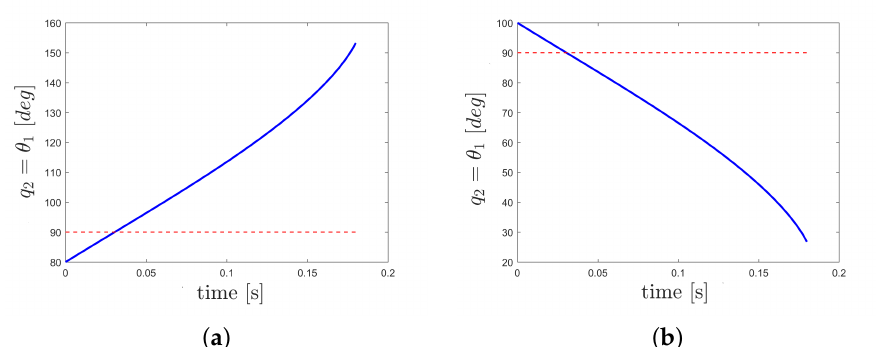
Figure 3. Solutions of zero dynamics (22) obtained for: ( a ) positive velocity, ( b ) negative velocity. The used values of parameters correspond to the particular system investigated in Section 4. The dotted lines present the value θ r 1 = π /2 where the system is assumed to be stabilized.